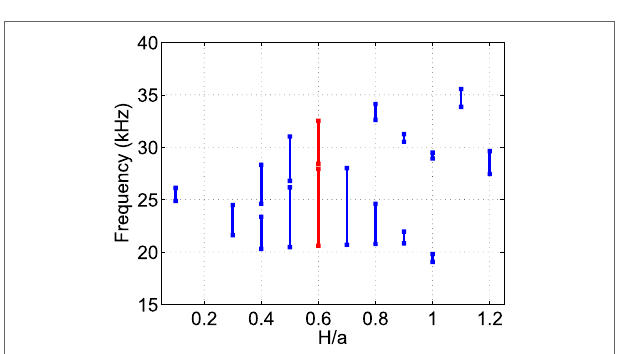
FigUre 4 | BG frequencies versus the unit cell thickness to lattice parameter ratio H/a . The ratio leading to the widest total BG is highlighted in red.